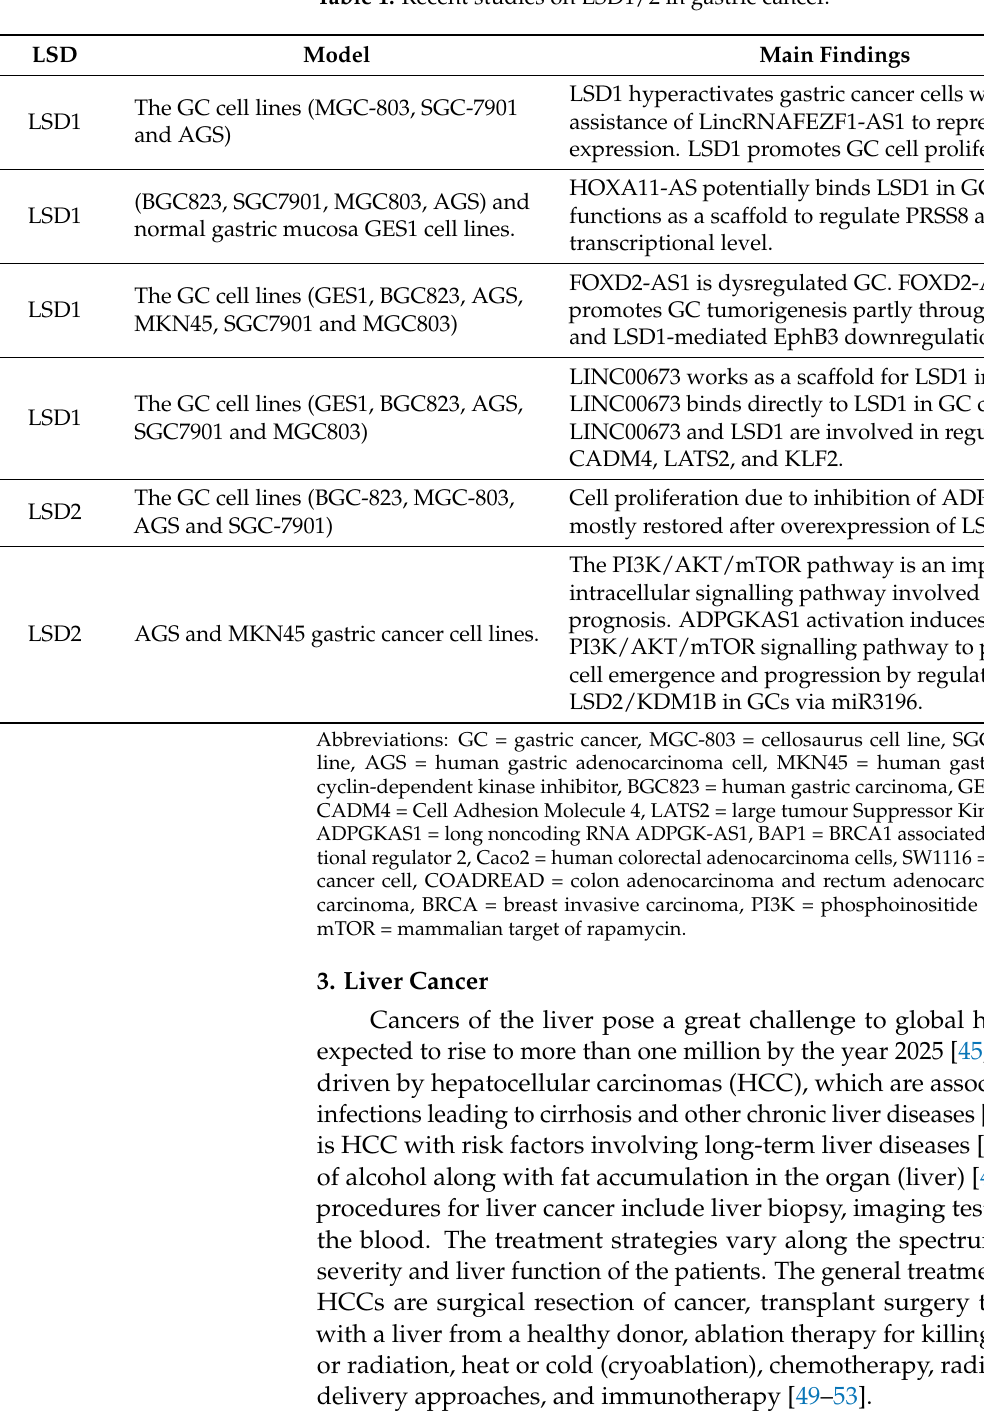
Table 1. Recent studies on LSD1/2 in gastric